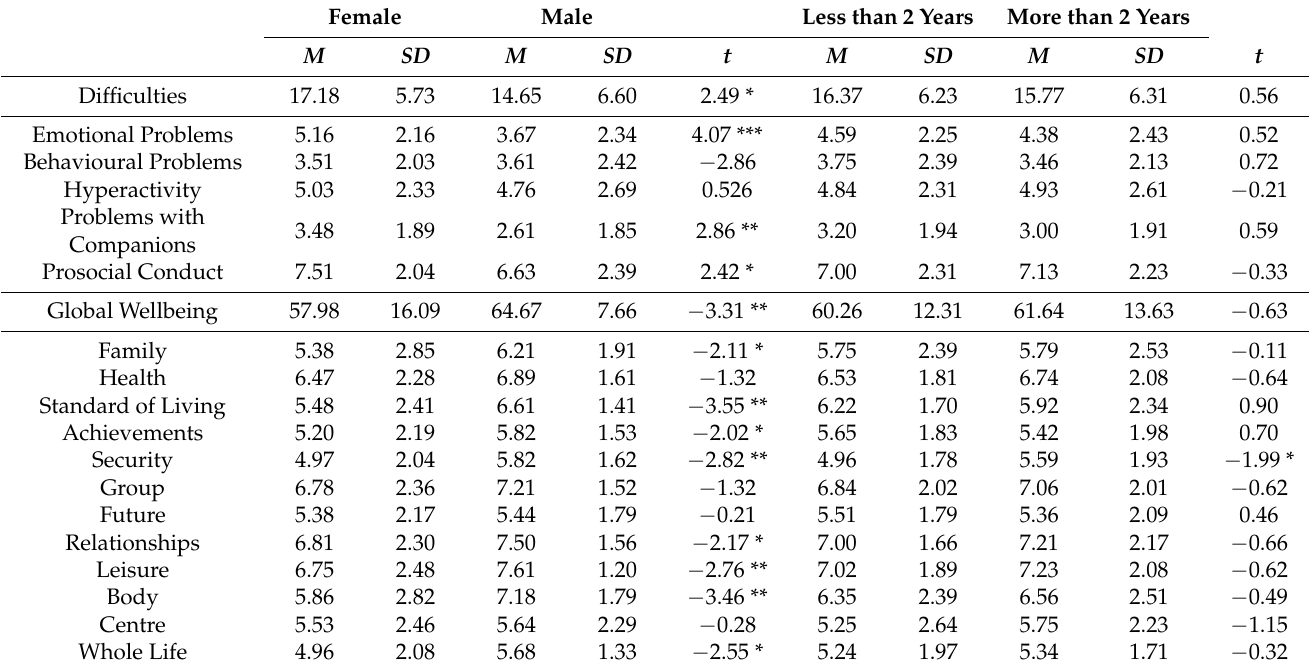
Table 2. Comparison of the means of the difficulties and personal wellbeing according to gender and the time spent in care.